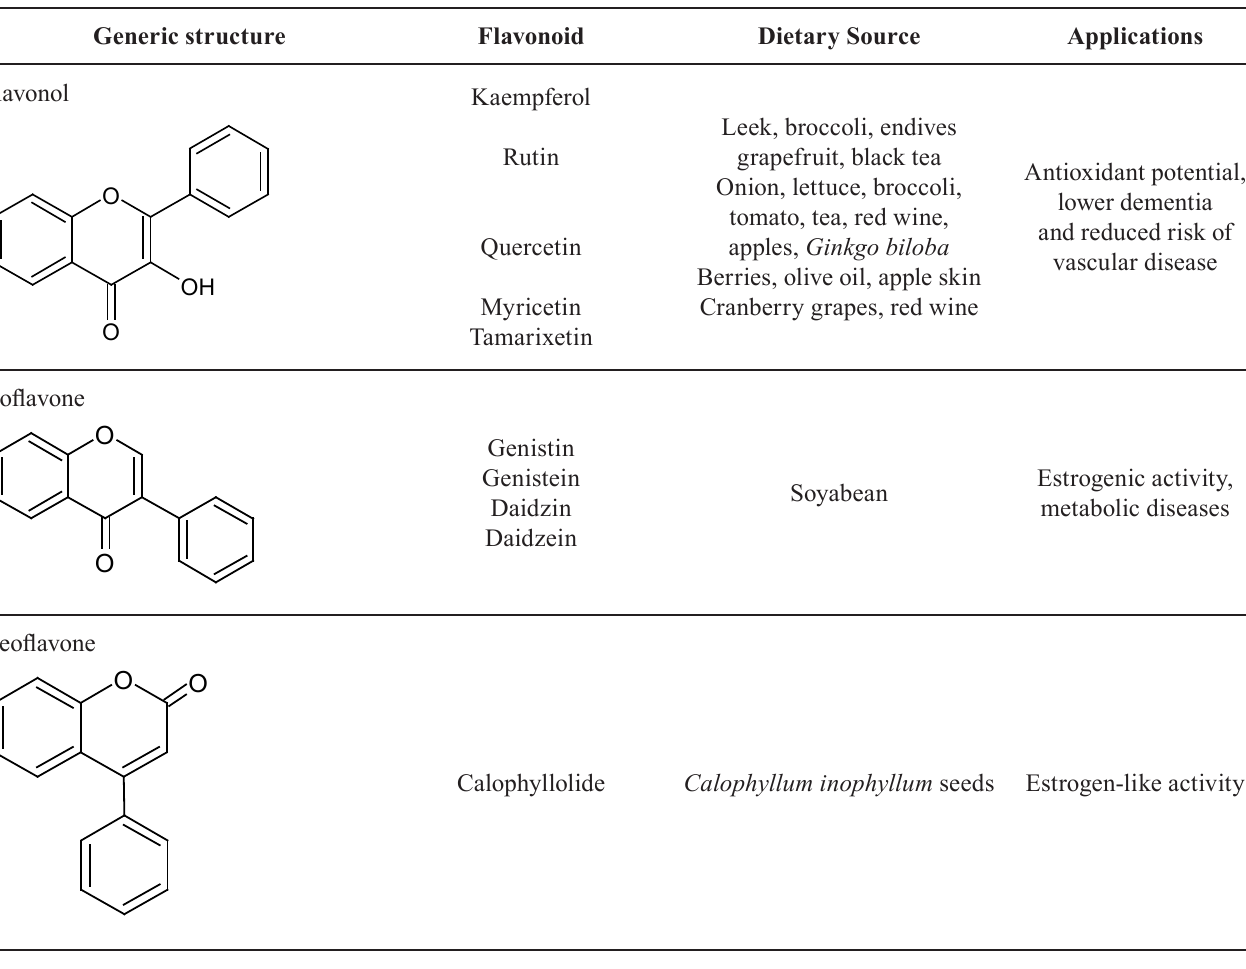
Generic structure